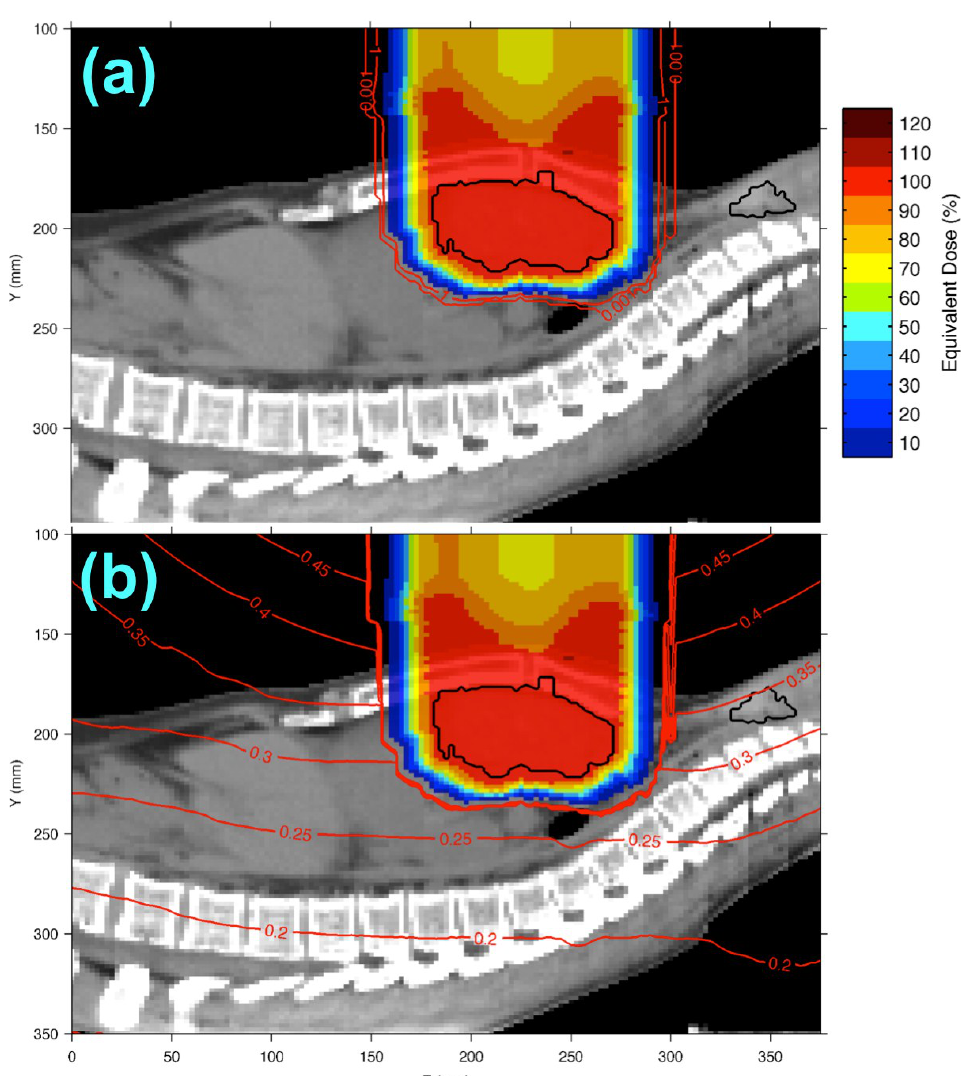
Figure 2. Sagittal equivalent dose planes overlaying a thoracic CT image of the HL patient showing ( a ) proton equivalent dose and ( b ) combined proton and neutron equivalent